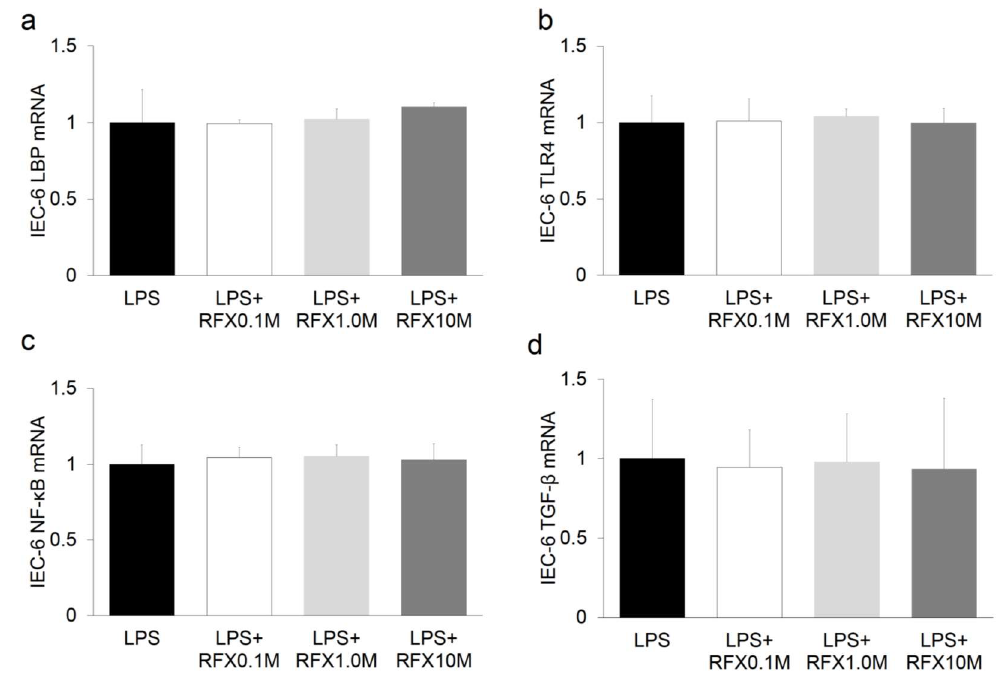
Figure 7. In vitro study of the effect of an RFX on intestinal epithelial cells using IEC-6. ( a ) LBP, ( b ) TLR4, ( c ) NF-kB, and ( d ) TGF-β.RFX did not influence IEC-6.